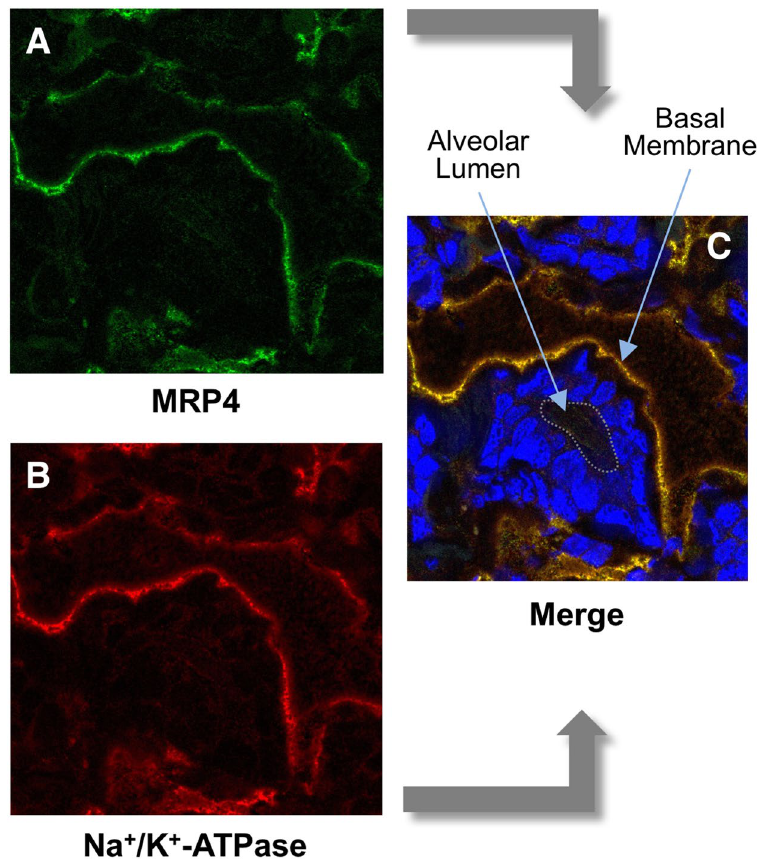
Figure 4. Immunofluorescence localization of MRP4 in breast tissue of a non-lactating woman. Cryosections were stained with anti-MRP4 ( A , green) and anti-Na + /K + -ATPase ( B , red) antibodies. Co-localization of both signals is shown in C . Nuclei were stained with DAPI.